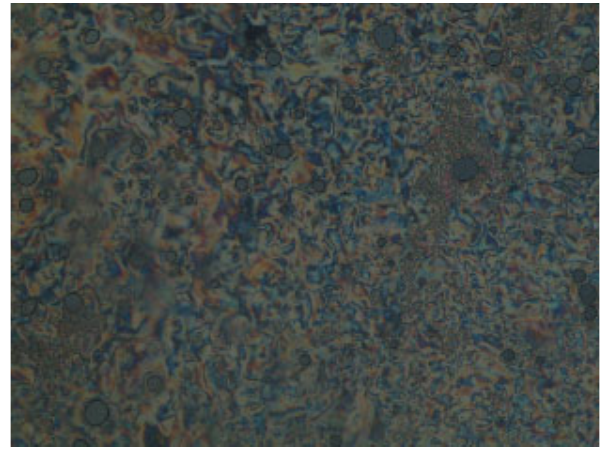
Figure 2. Nematic pattern under POM of compound 8 at 130.0 °C upon heating.